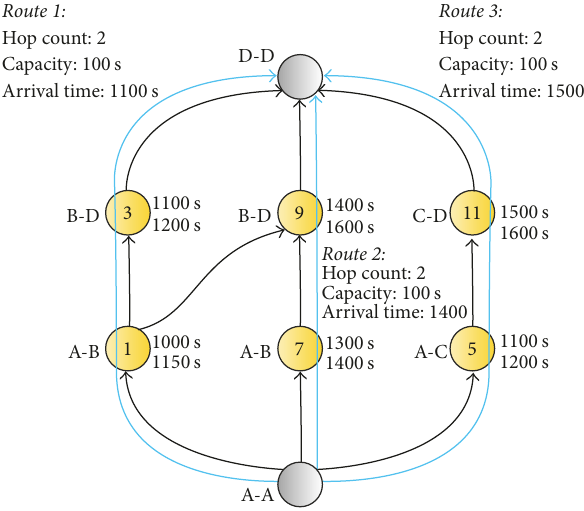
Figure 3: Contact graph